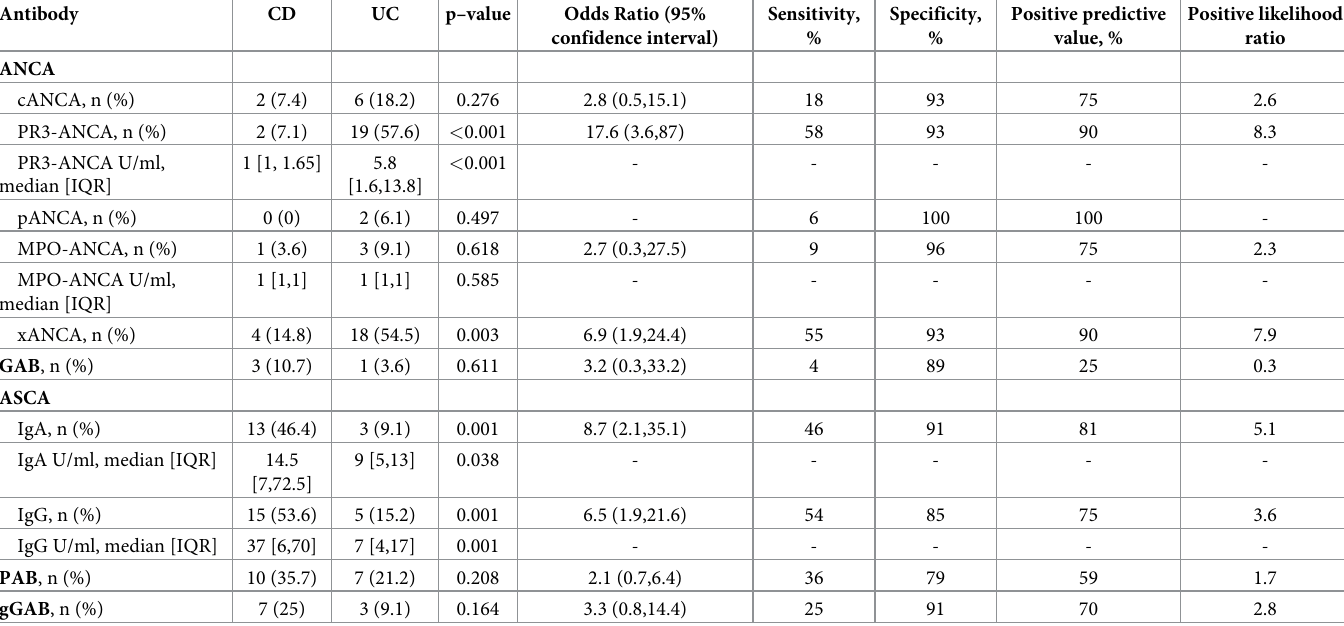
Table 2. Antibody association with ulcerative colitis and Crohn’s